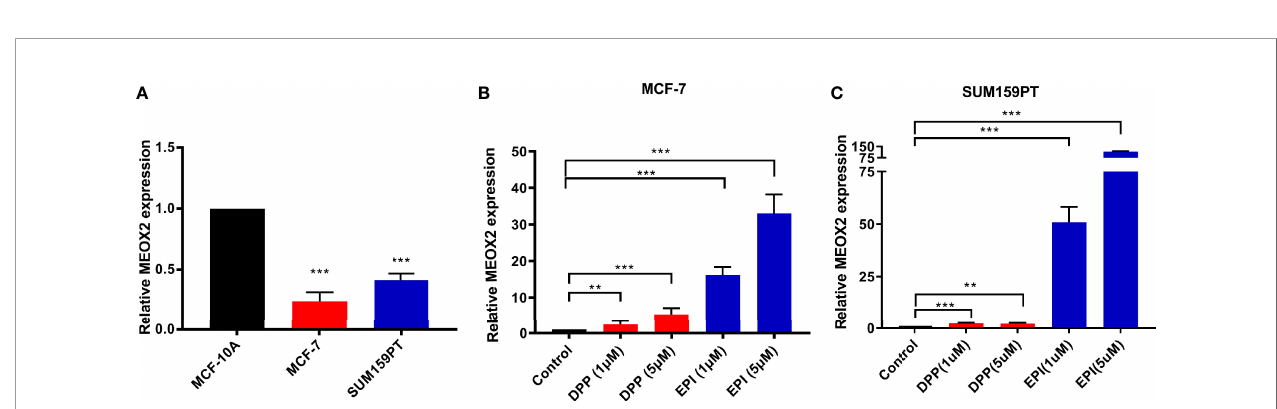
FIGURE 5 | MEOX2 mRNA expression detected with real-time PCR (A) in MCF-10A and MCF-7 cells; (B) in MCF-7 cells treated with DDP (1 or 5 m M) or EPI (1 or 5 m M) for 24 h; (C) in SUM 159PT cells treated with DDP (1 or 5 m M) or EPI (1 or 5 m M) for 24 h. Quantitative data are indicated as mean ± SEM. ** p < 0.01; *** p < 0.001).